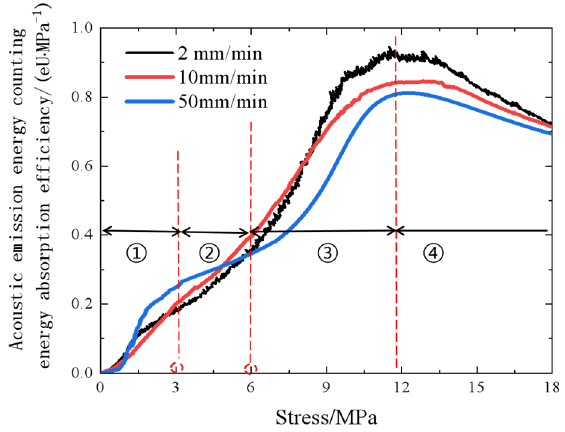
Figure 10. AE energy absorption efficiency curve of open-cell aluminum foam.